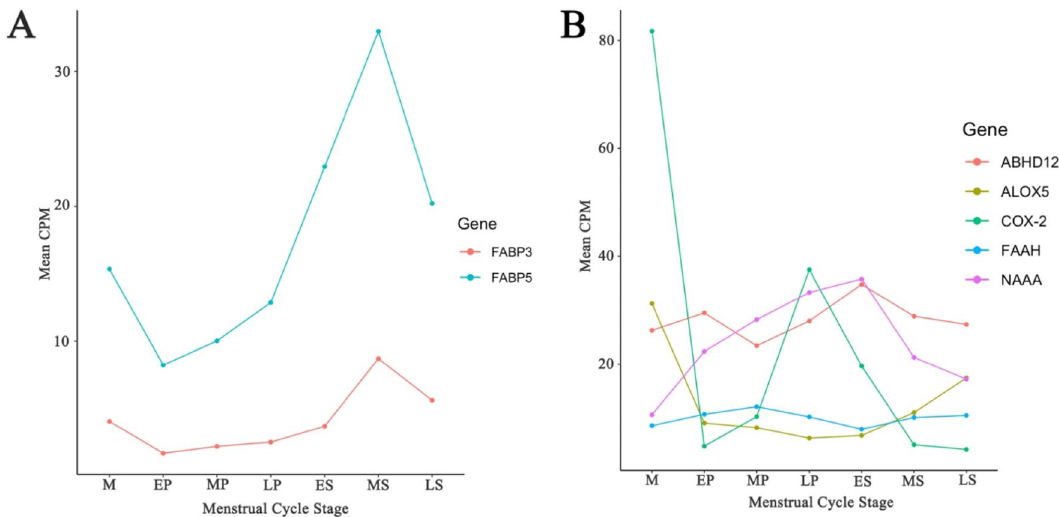
Figure 3. The expression profile of genes encoding ECS transport and degrading proteins. Transcription expression that showed a significant difference at any stage in the menstrual cycle were plotted against cycle stage. ( A ) For the transporting proteins moderate expression was observed for FABP5 and FABP3 that was significantly increased across the menstrual cycle. ( B ) ECS degrading enzymes had a moderate to low expression that were most commonly altered between the menstrual and early proliferative stage, or during the period from the late proliferative to mid secretory stage. Two genes ABHD12 and NAAA showed a consistent increase over the proliferative stage, after which there was decrease in expression. M = Menstrual, EP = Early proliferative, MP = Mid proliferative, LP = Late proliferative, ES = Early secretory, MS = Mid secretory, LS = Late